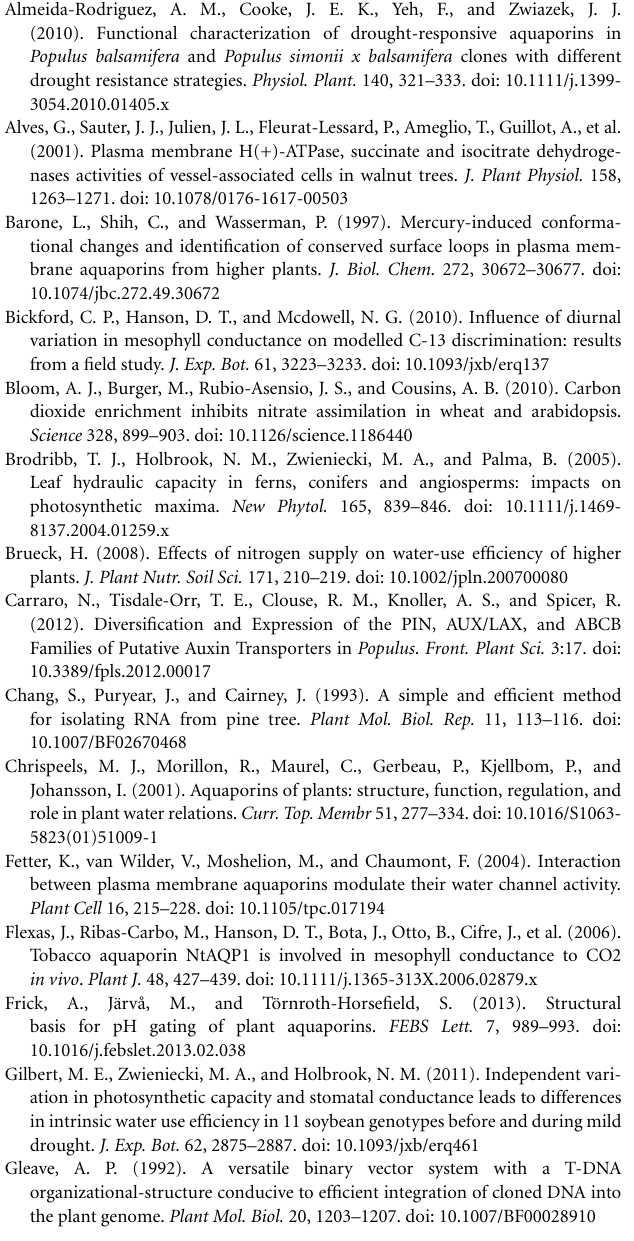
Supplemental Table 1 | Sequences of primers used for quantitative real time